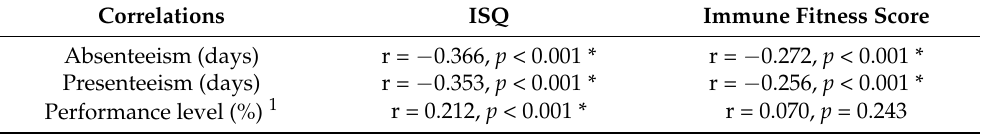
Table 3. Correlations between immune fitness (ISQ or single item immune fitness score), absenteeism, presenteeism, and work performance on days with reduced immune